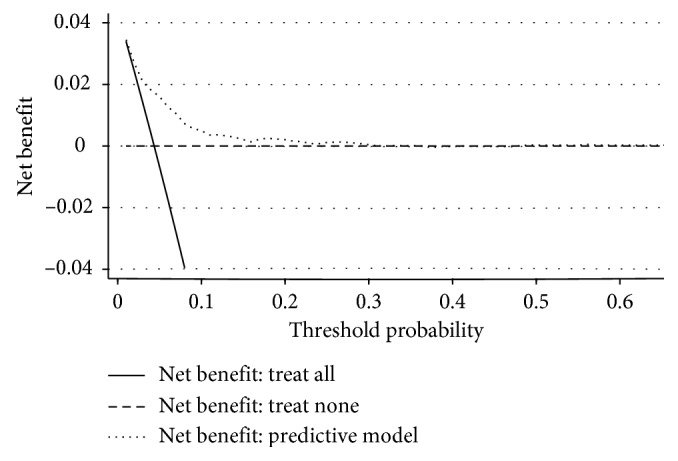
Decision curve analysis of the predictive model. The dotted line represents the model. Area among the dotted line, the solid line, and the dashed line represents the net benefit from applying this model for prediction of TB transmission in households exposed to TB patients. The decision curve shows that when the threshold probability of a patient is <30%, application of this mode adds more benefit than either the treat-all or the treat-none strategies.